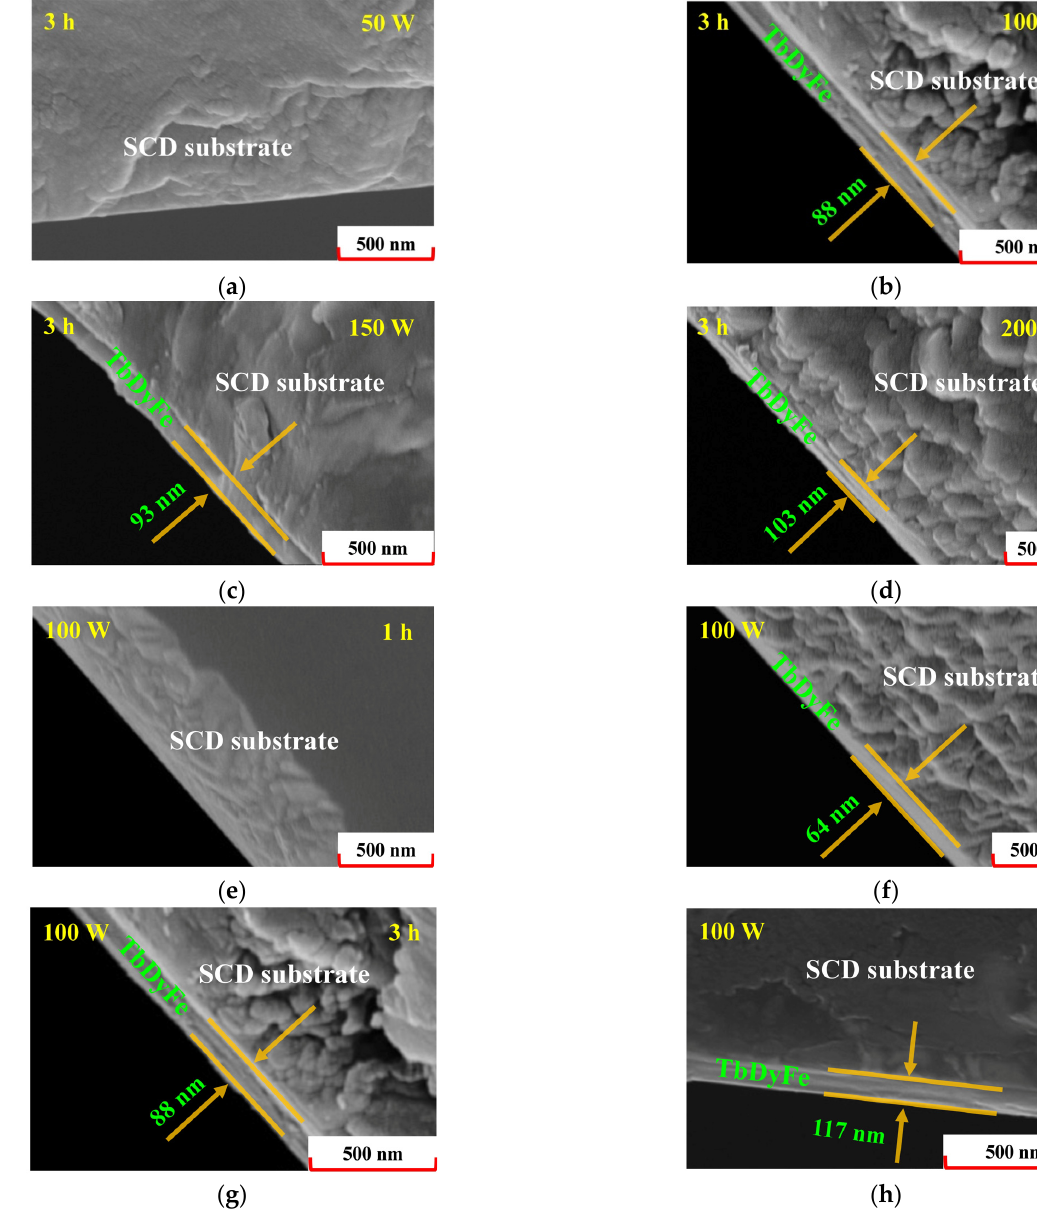
Figure 3. SEM images of TbDyFe film cross sections under different ( a – d ) sputtering powers (50 W, 100 W, 150 W, and 200 W, respectively) and ( e – h ) deposition times (1 h, 2 h, 3 h, and 4 h, respec- tively).